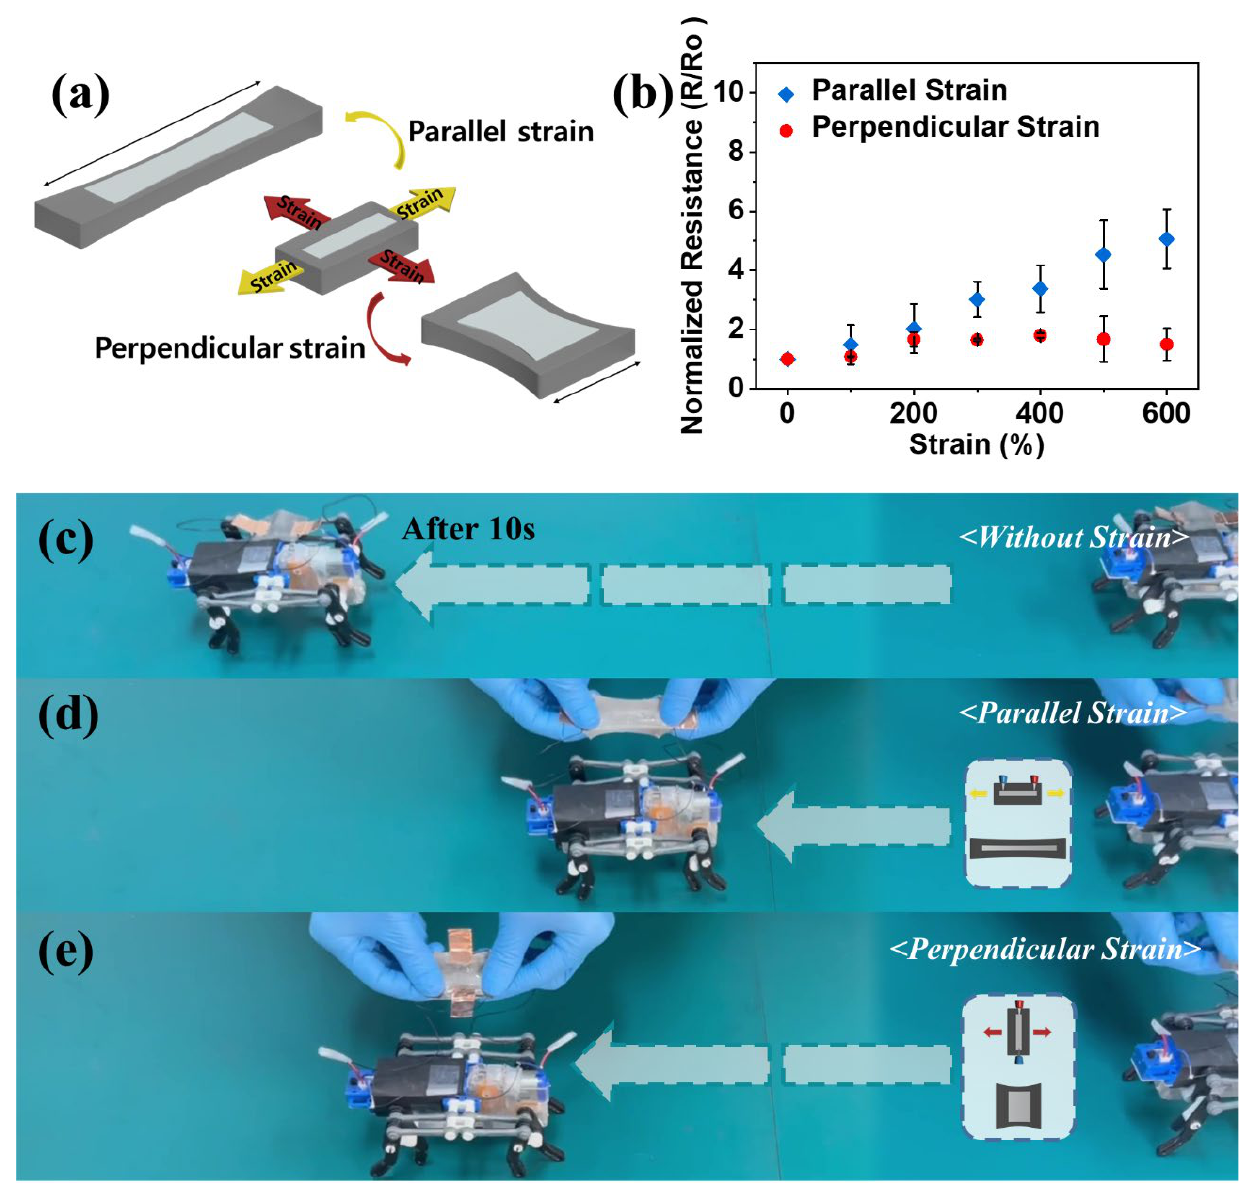
Figure 6. Liquid metal elastomer films exhibiting anisotropic conductivity. ( a ) Schematic showing the geometrical change of the liquid metal elastomer film with handwritten circuit upon strains parallel and perpendicular to the direction of the conductive trace. ( b ) Normalized resistance versus strain for the conductive trace upon parallel and perpendicular strains. ( c – e ) Photographs showing the locomotion of a robot enabled by the liquid metal elastomer film connected ( c ) without strain, ( d ) with parallel strain along the direction of the conductive trace, and ( e ) with perpendicular strain along the direction of the conductive trace.